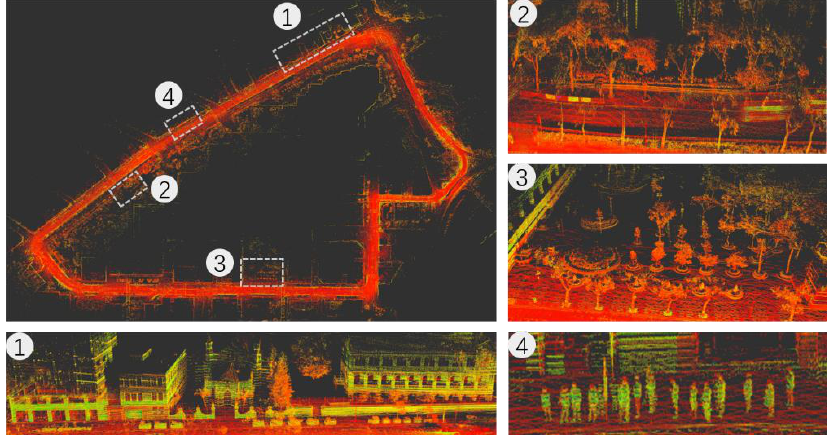
Figure 16. The map is generated by LC-LIO-AC in the urban canyon 2 and rendered with intensity value. The top left panel presents the entire map in a bird-eye view. The four places marked in the entire map are zoomed in and the details are shown with the same number marked on the panel.